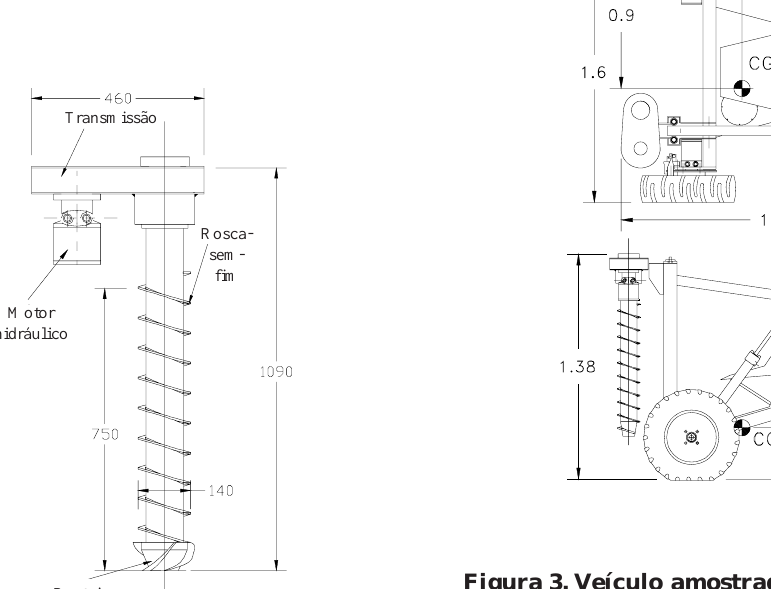
Figura 3. Veículo amostrador de solos (VAS), com as principais dimensões e localização do Centro de Gravidade